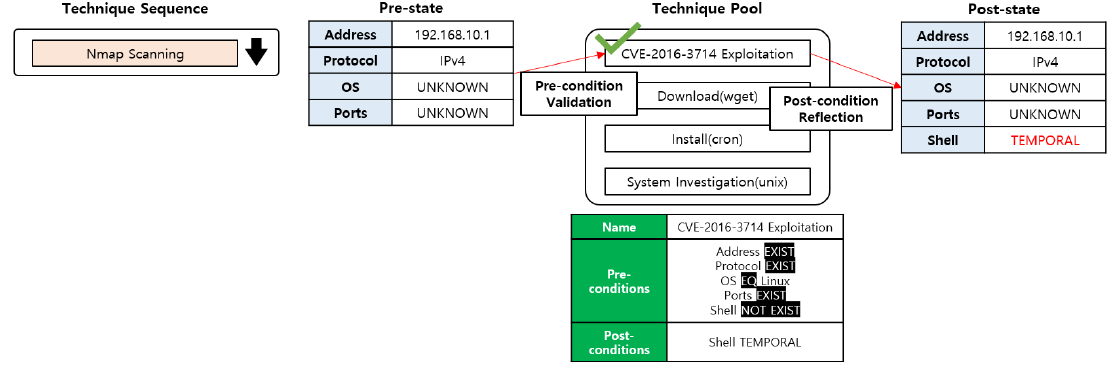
Figure 2. The example of the process of scenario generation: port scanning chosen.